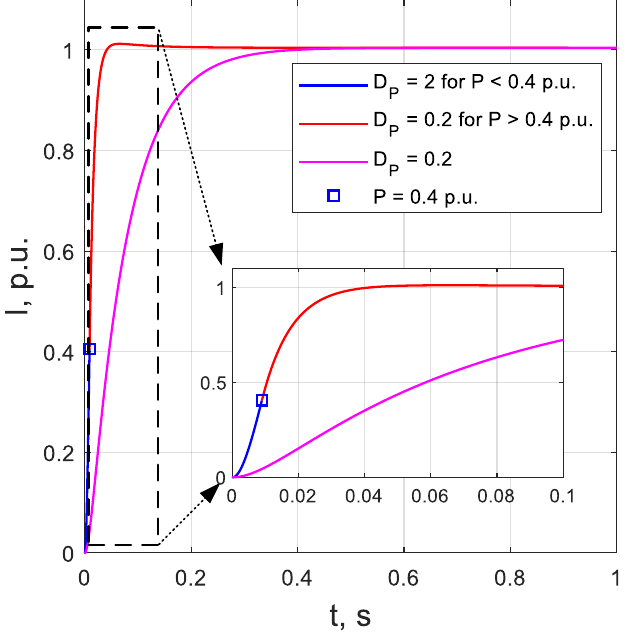
Figure 12. Active power curves for systems with variable D p restart and systems with constant D p of 0.2 p.u./Hz.